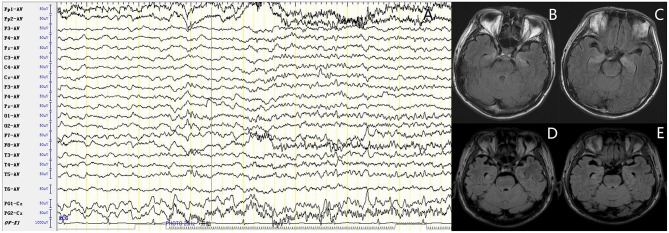
Case 4, male, 62 years old, who was diagnosed with leucine-rich glioma-inactivated 1 protein (LGI1) antibody associated autoimmune encephalitis (AE). (A) Ictal electroencephalogram (EEG) of a subclinical seizure showed rhythmic sharp wave discharges in bilateral temporal regions, with amplitude and frequency modulated gradually. (B,C) Twenty-three days after onset and before immunotherapy, brain MRI showed high T2/fluid-attenuated inversion recovery (FLAIR) signal on bilateral hippocampus. (D,E) About 3 months after onset and after immunotherapy, brain MRI showed significant improvement in the high T2/FLAIR signal on bilateral hippocampus.